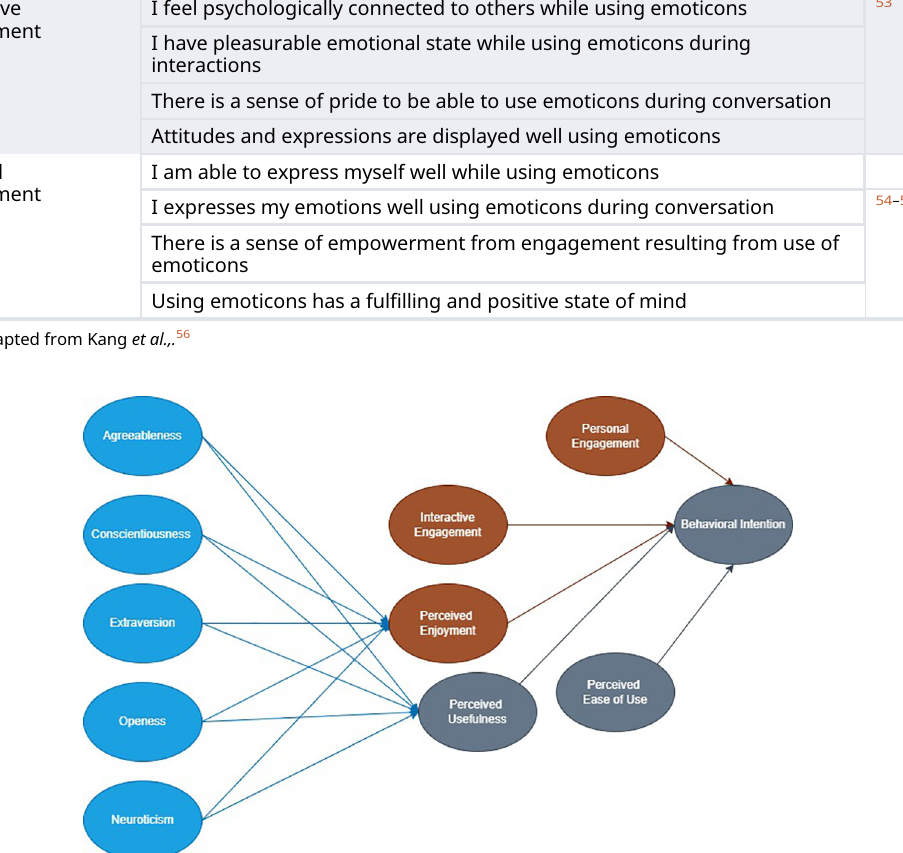
Table 1. The applied conceptual framework is presented in Figure 1.